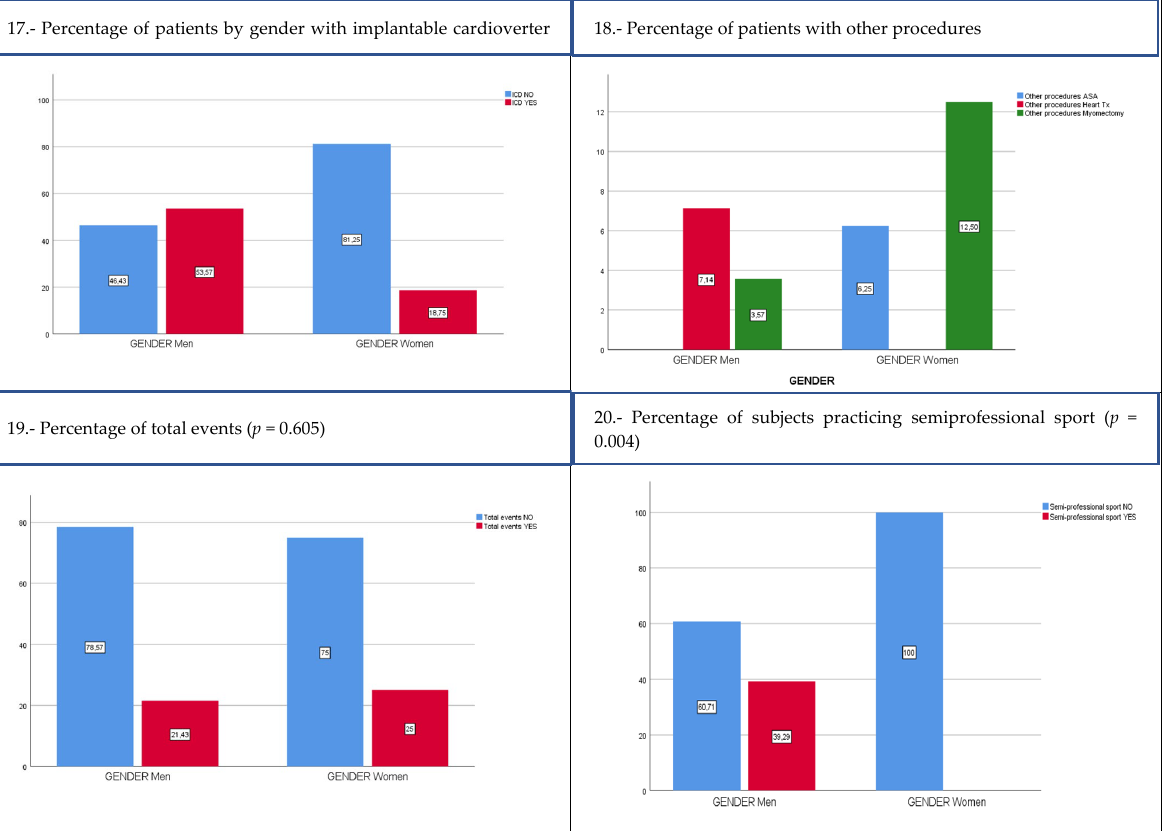
Figure A1. Graphic Representation of the Data Included in Table 1 separated by gender and differ- ences expressed with p value. Simple bar graphs represent percentage of patients.